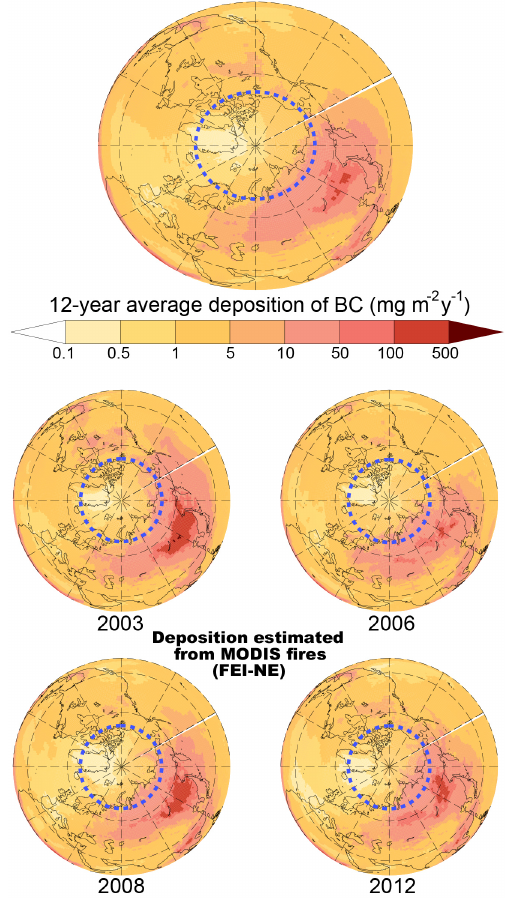
Figure 2. Arctic deposition of BC (mgm − 2 yr − 1 ) from BB emis- sion according to the FEI-NE inventory. The upper panel depicts the 12-year average deposition, while the lower four panels show the most intense fire years (2003, 2006, 2008, and 2012). The dashed blue line represents the border of the Arctic ( ∼ 67 ◦